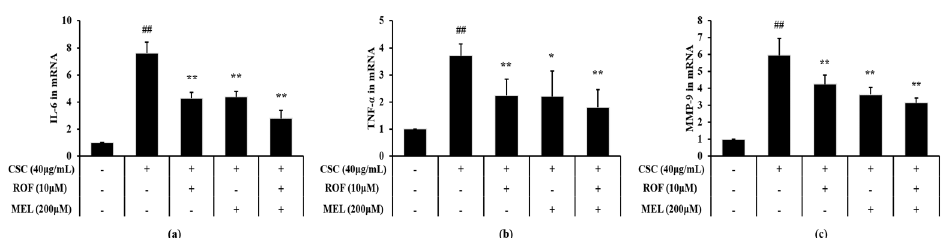
Figure 6. Melatonin reduced mRNA expression of inflammatory cytokines and MMP-9 in CSC- stimulated cells. The level of mRNA expression of inflammatory cytokines and MMP-9 was deter- mined by real-time PCR. ( a ) IL-6 , ( b ) TNF- α , ( c ) MMP-9 . This experiment was repeatedly performed three times. ## Significantly different from the non-treated cells, p < 0.01; *,** significantly different from the CSC-stimulated cells, p < 0.05 and < 0.01, respectively.